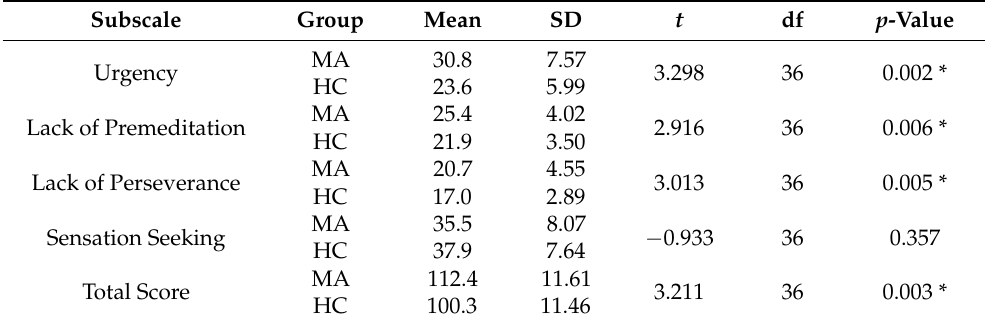
* p -values survive the Bonferroni correction.